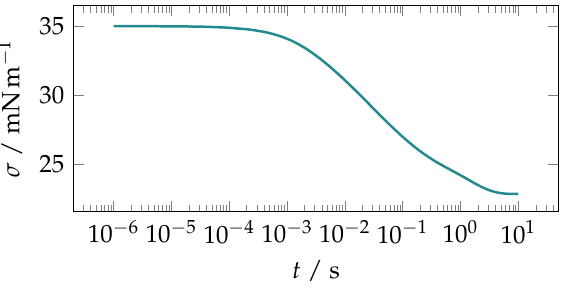
Figure 1. Dynamic surface tension over surface age with the model parameters presented in Section 2.3.